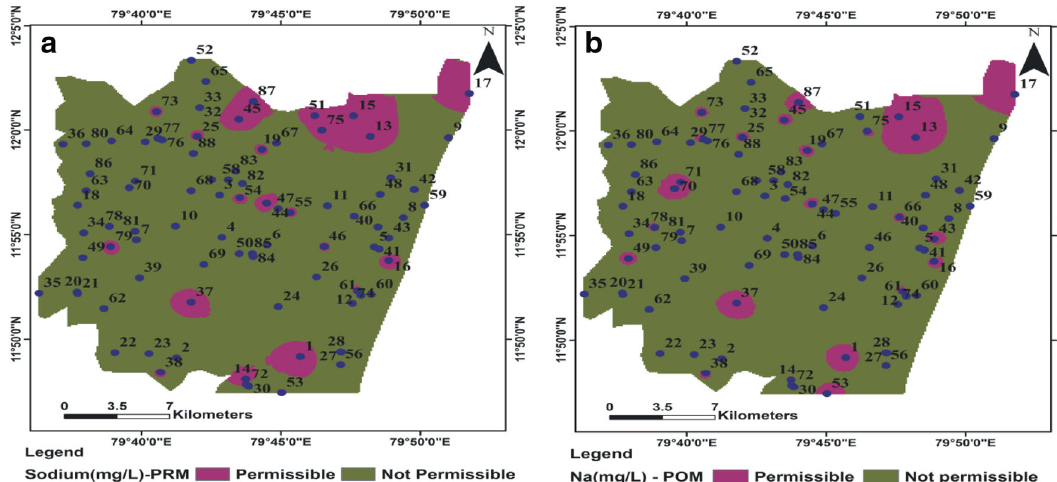
Fig. 6 a , b Spatial distribution map of Na (pre- and